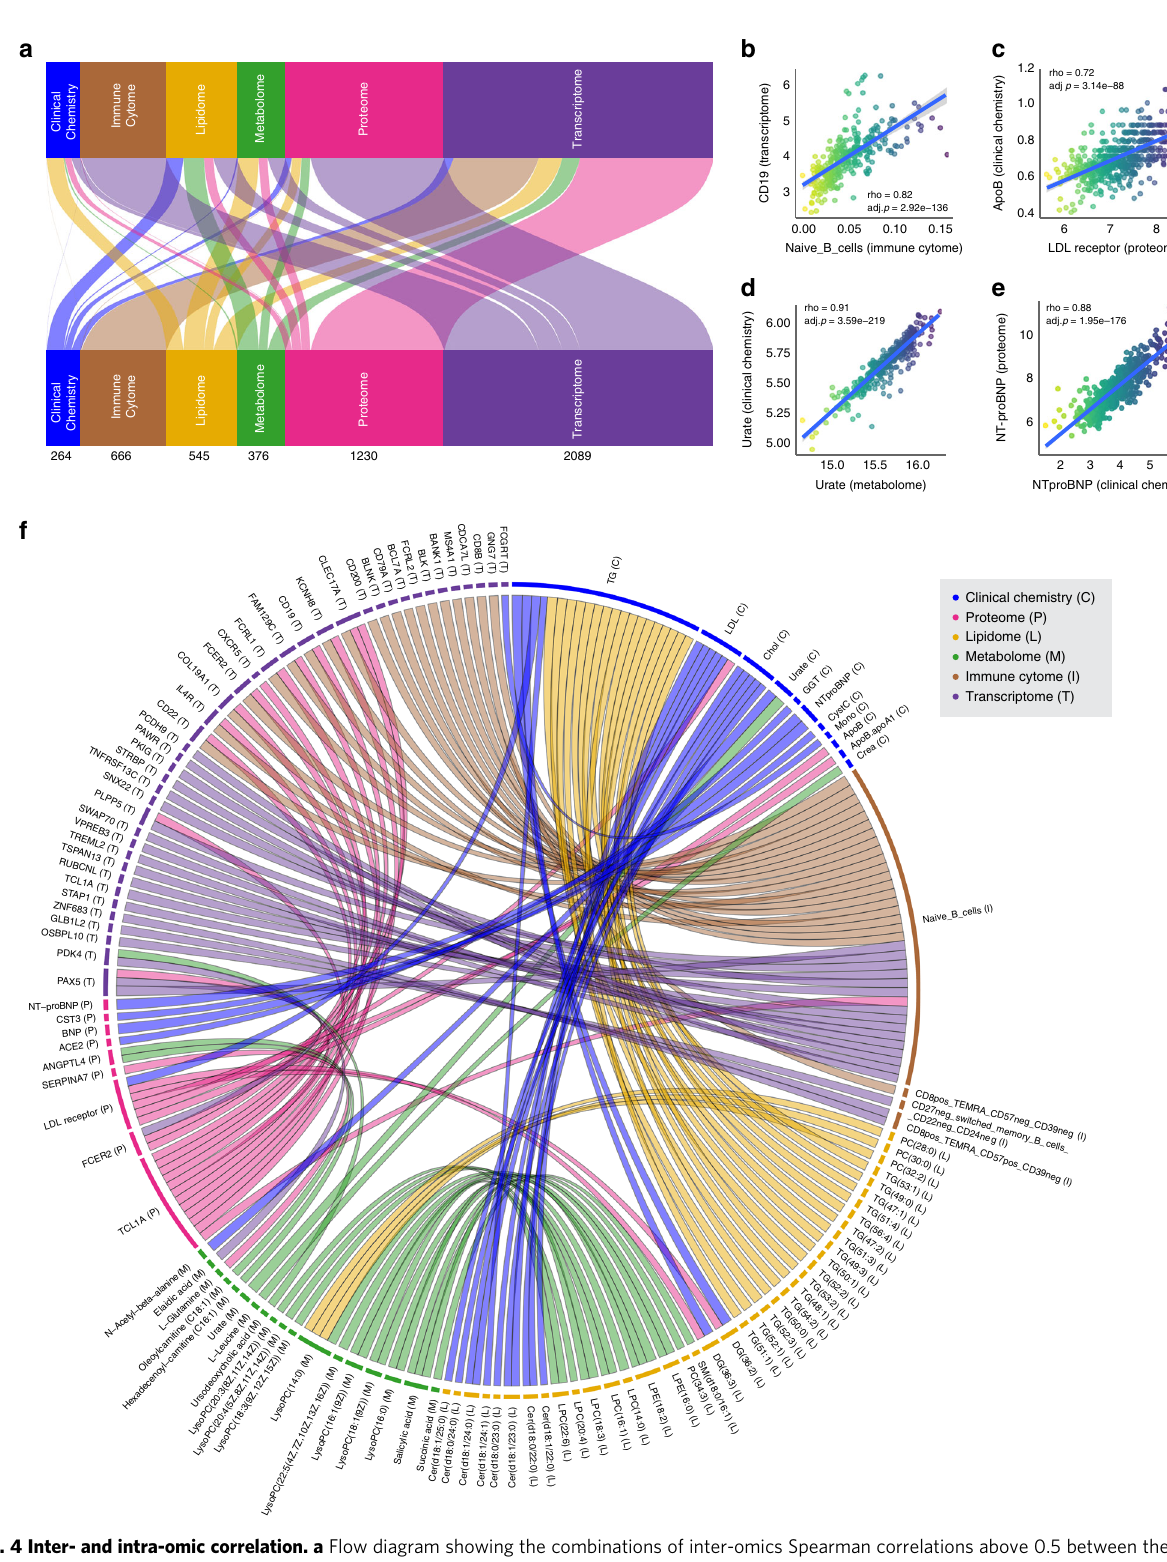
Fig. 4 Inter- and intra-omic correlation. a Flow diagram showing the combinations of inter-omics Spearman correlations above 0.5 between the different datasets. The numbers represent the number of features correlating between two datasets. Selected examples of highly correlated variables between two datasets using spearman correlation: b CD19 and naïve B cells, c ApoB and LDL receptor, d Urate, and e NTproBNP. f Chord diagram of the top 20 inter- omic Spearman correlations for each of the datasets. The ribbon thickness re fl ects the spearman correlation. Multiple test corrections have been applied for p values using Benjamini and Hochberg